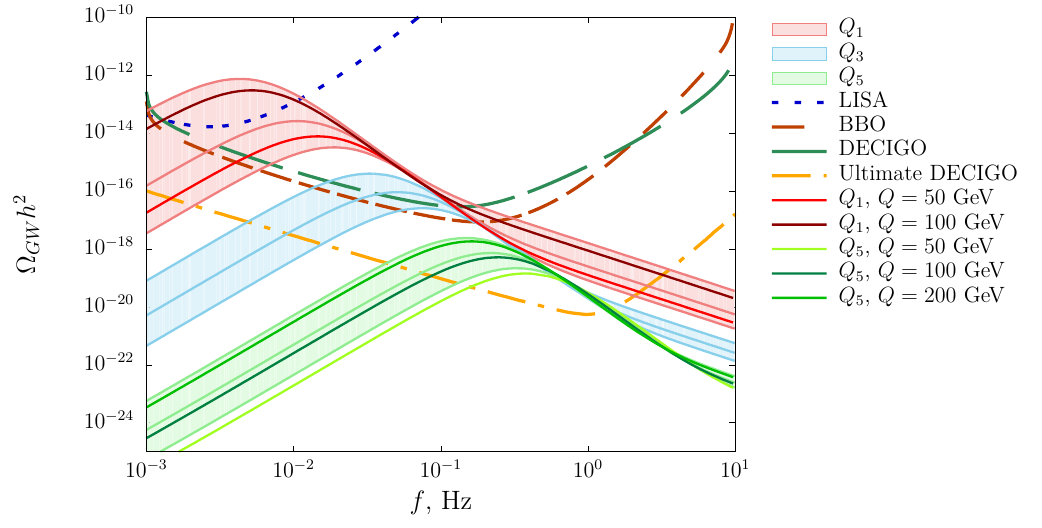
Figure 4 . Solid lines: the gravitational wave spectra from the first-order phase transition for points Q 1 and Q 5 computed adopting the renormalization scale as Q = 50 GeV, 100 GeV and 200 GeV. For point Q 1 with Q = 200 GeV the bubble nucleation does not take place. Filled bands: the GW spectra for points Q 1 , Q 3 , Q 5 for the variation of the renormalization scale from 2 T perc (upper edges) to T perc / 2 (bottom edges) through T perc (central